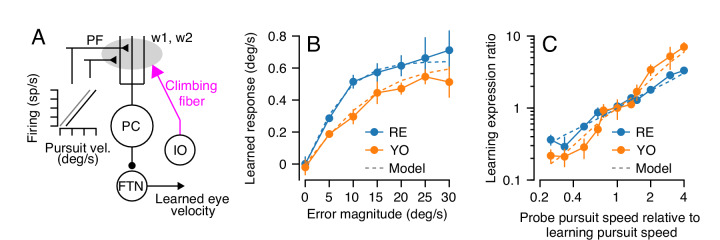
Properties of a cerebellar model of single-trial learning with a single site of plasticity.(A) Simplified model of cerebellar learning with a single-site of plasticity at the parallel fiber to Purkinje cell synapse (gray shaded oval). Abbreviations are the same as in Figure 1. In this single-learning-process model, the firing of parallel fibers is linearly related to the speed of the eye in the pursuit direction. (B) Dashed lines show the model’s prediction of learned responses as a function of error magnitude. Filled symbols connected by lines are reproduced from Figure 3C. (C) Learning expression ratio as a function of the ratio of pursuit speed in the probe trial to the pursuit speed in the learning trial (note that both axes are on a log scale). By definition, the learning expression ratio is ~1.0 when the pursuit speed in the probe trial and the preceding learning trial are identical. As in (B), dashed lines show the prediction of the single-learning-process model and symbols connected by lines summarize data from the two monkeys. Error bars show ± SEM across experiments for each monkey.Figure 5—source data 1.Figure composer source data comparing the single-site model of cerebellar learning with behavioral results.